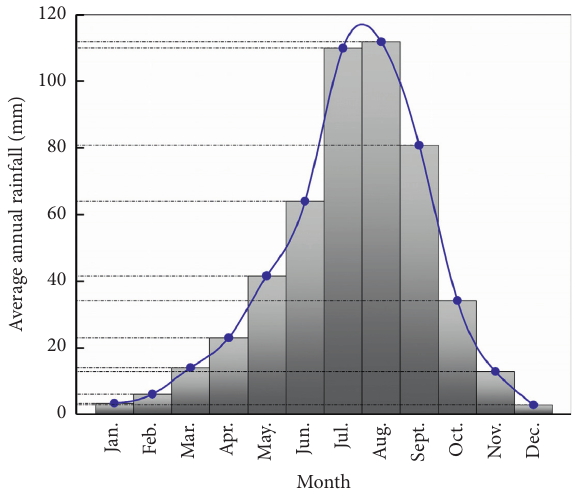
Figure 4: The monthly distribution of the average annual rainfall applied in Lvliang Airport.